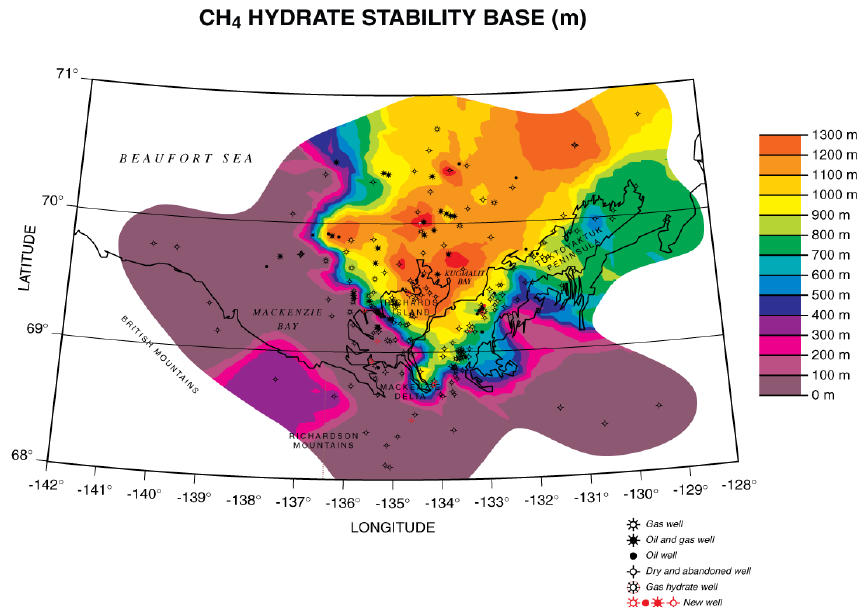
Fig. 1. Depth to GH base of Type I stability in the Mackenzie Delta. Model studies were performed for northern Richards Island and its adjacent offshore (near the centre of the figure).